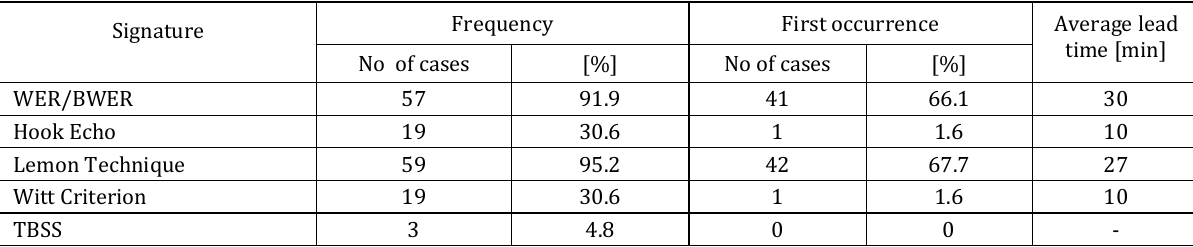
Table 1. The frequencies of reflectivity signatures and criteria for 62 hailstorms considered first occurrence” means that given signature appeared as the first hail signal